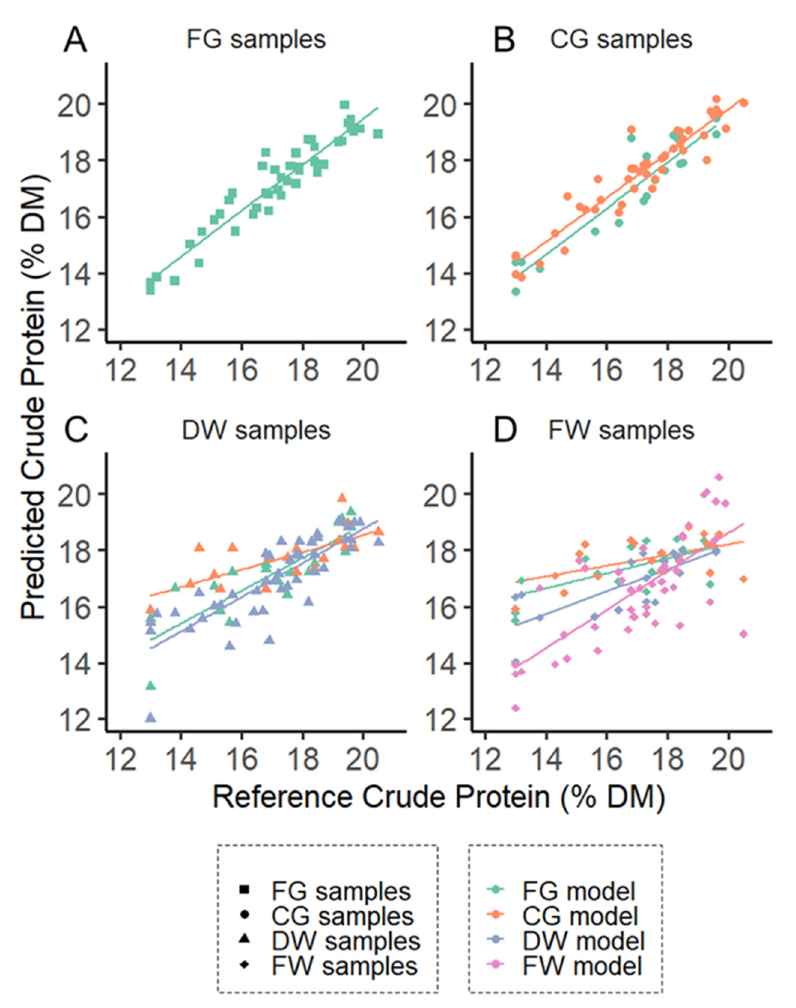
Figure 8. Predicted vs. Reference values of CP. Fine–Ground samples using Fine–Ground model ( A ), Coarse–Ground samples using Fine–Ground and Coarse–Ground models ( B ), Dry–Whole samples using Fine–Ground and Coarse–Ground models ( C ), and Fresh–Whole samples using Fine–Ground, Coarse–Ground, and Dry–Whole models ( D ). SBC was used in each mode cloning.